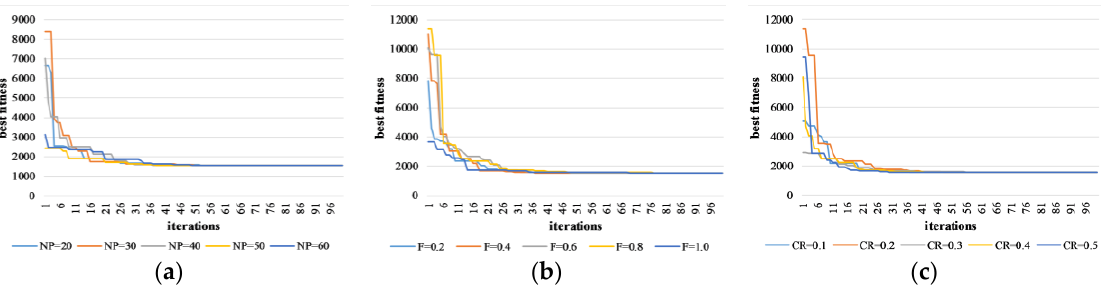
Figure 14. Relationship between the performance and different parameters of DE. ( a ) Performance with different population size NP . ( b ) Performance with different initial scale factor F 0 . ( c ) Performance with different initial crossover rate CR 0 .